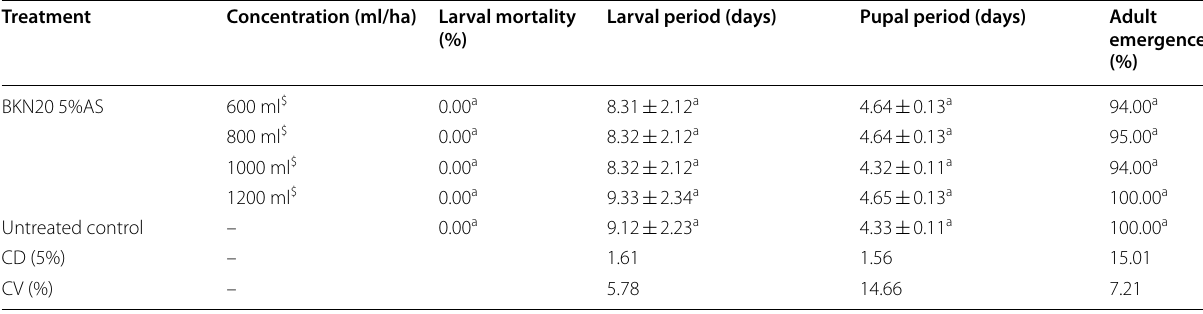
Means followed by similar letters in a column are not significantly different at 5% (DMRT F-Test, p > 0.05) $ Containing 2 10 7 conidia/ml ×